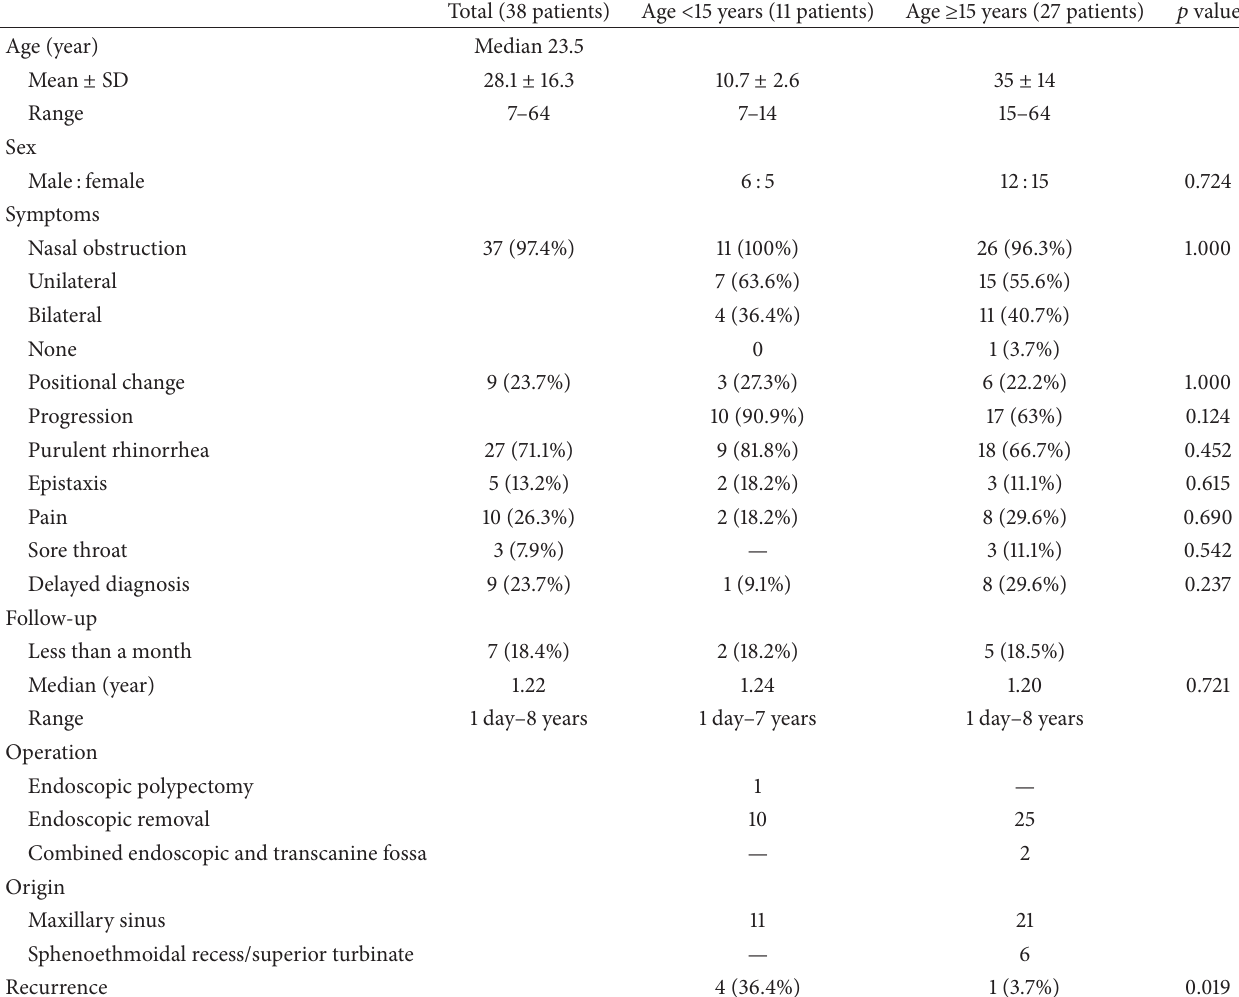
Table 1: Patient characteristics according to age